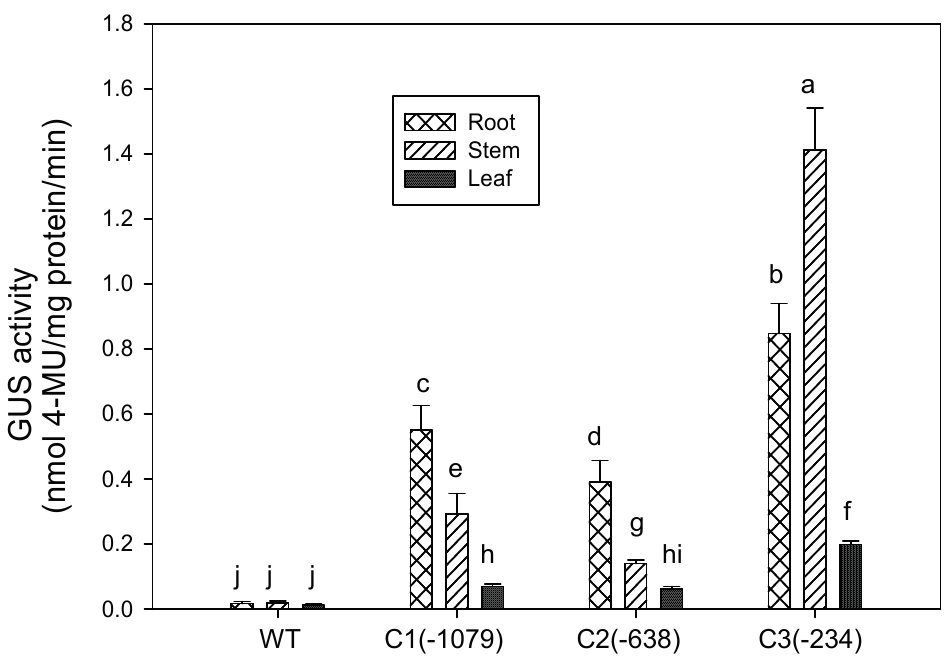
Figure 6. Tissue-specific expression analysis of GUS activity among different transgenic Arabidopsis lines. GUS activity was examined in six-week-old Arabidopsis T3 plants and wild type (WT). GUS activity was analyzed fluorometrically and expressed as nmoles 4-methylumbelliferone (MU)/mg protein/min. Data are expressed as the mean ± standard deviation of three independent assays involving Arabidopsis leaf extracts. The same letters indicate no significant differences at p ≤ 0.05 by Duncan’s test. Different letters (a–j) mean statistical differences between